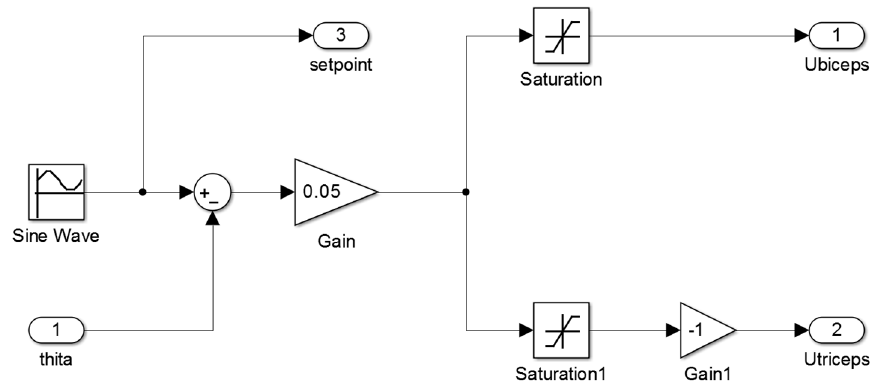
Figure A.3. Human Brain’s behavior model Figure A3. Human Brain’s behavior model.